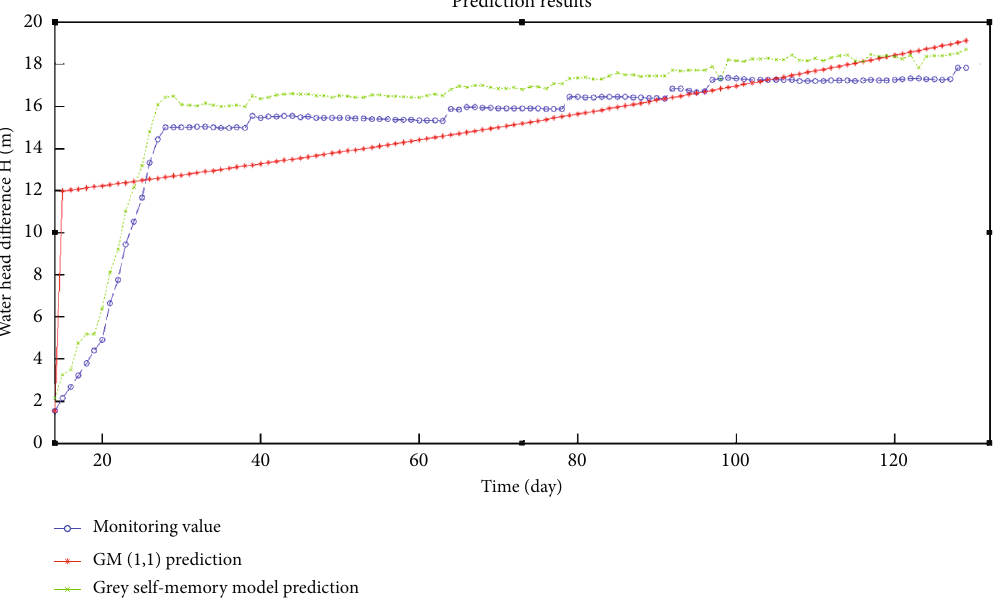
Figure 8: The comparison of prediction value and monitoring value at the point UP1. Table 1: The comparison of errors between the monitoring datum and predicting value.